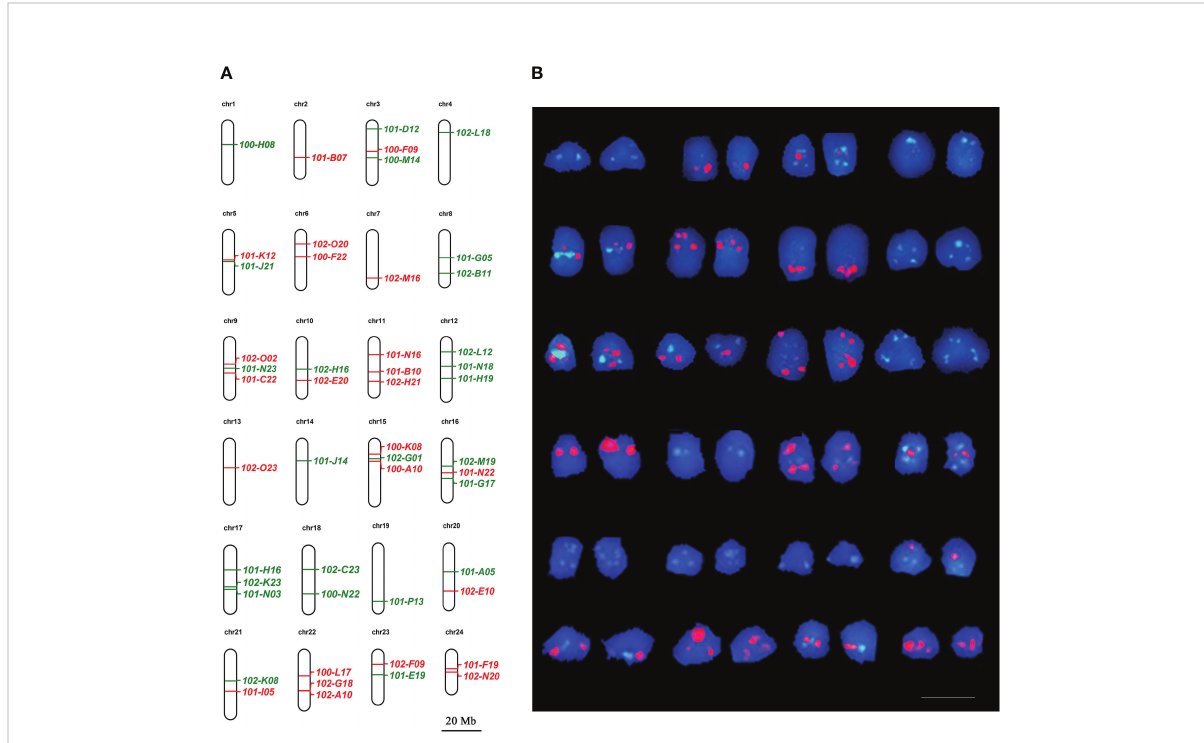
FIGURE 3 Correspondence between metaphase chromosomes and pseudochromosomes in large yellow croaker. (A) Pseudochromosomes with BAC clones showing the putative locations and signal colors. Bar represents 20 Mb for psedochromosomes. (B) Metaphase chromosomes arranged according to pseudochromsome base on FISH signal pattern. Red and green correspond to digoxigenin- and biotin-labeled probes, respectively. Bar represents 10 m m for metaphase